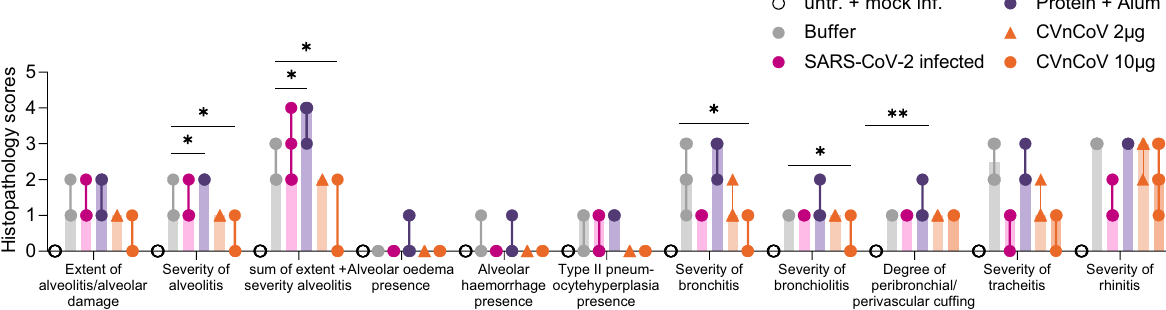
Fig. 5 CVnCoV protects the respiratory tract from challenge infection with no signs of vaccine-enhanced disease. Histopathological analyses of hamsters vaccinated with 10 or 2 µg of CVnCoV and 1.5 µg of Alum-adjuvanted S ECD protein or buffer on day 0 and d28, left untreated and mock-infected or infected intranasally (IN) with 10 2 TCID 50 /dose of SARS-CoV-2 on day 0 of the experiment followed by of SARS-CoV-2 challenge infection on d56. Histopathological analysis was performed on day 60, 4 days post challenge infection, on formalin- fi xed, paraf fi n-embedded tissues sections sampled on day 4 post challenge. Histopathological assessment scoring was performed according to severity of inspected parameter. Each dot represents an individual animal, bars depict the median. Statistical analysis was performed using Mann – Whitney